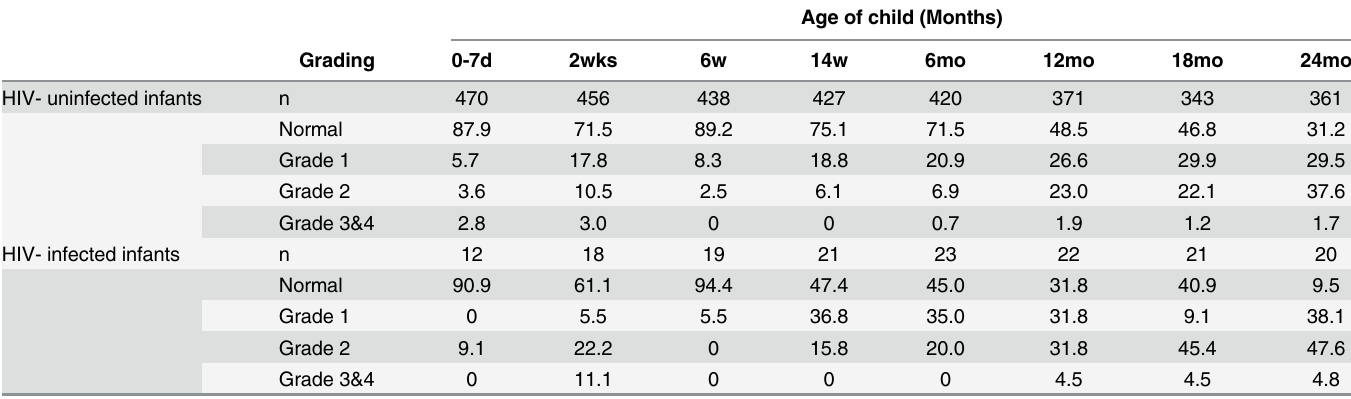
Table 1. Percent of HIV-uninfected and HIV-infected infants with normal and abnormal hemoglobin, Kisumu Breastfeeding study, Kisumu, Kenya, July 2003- February,